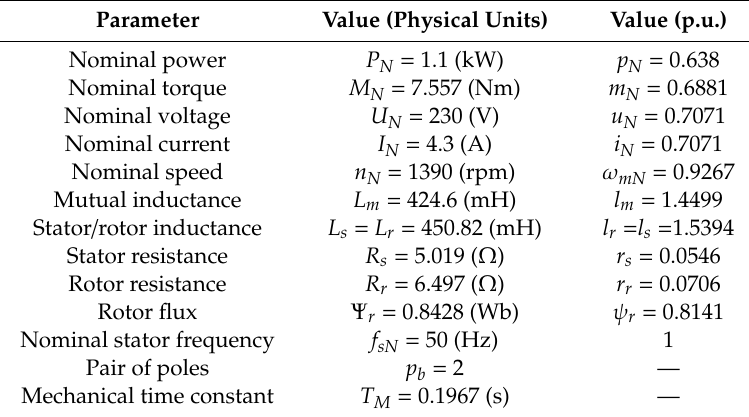
Table A1. Parameters of the tested induction